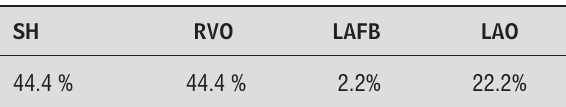
Table 2 - Types of electrocardiographic changes in the group studied (in percentages)